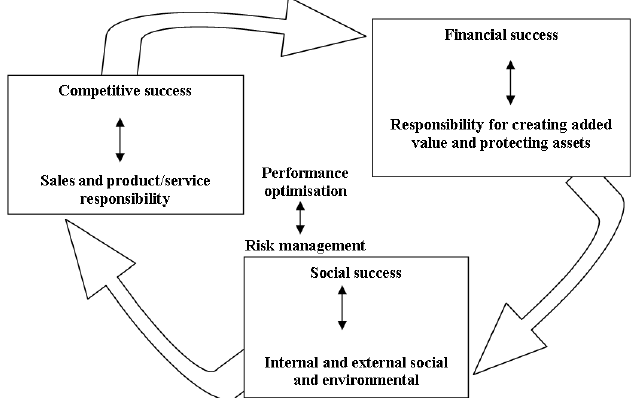
Figure 2: Degrees of Success, Risk Management and Corporate